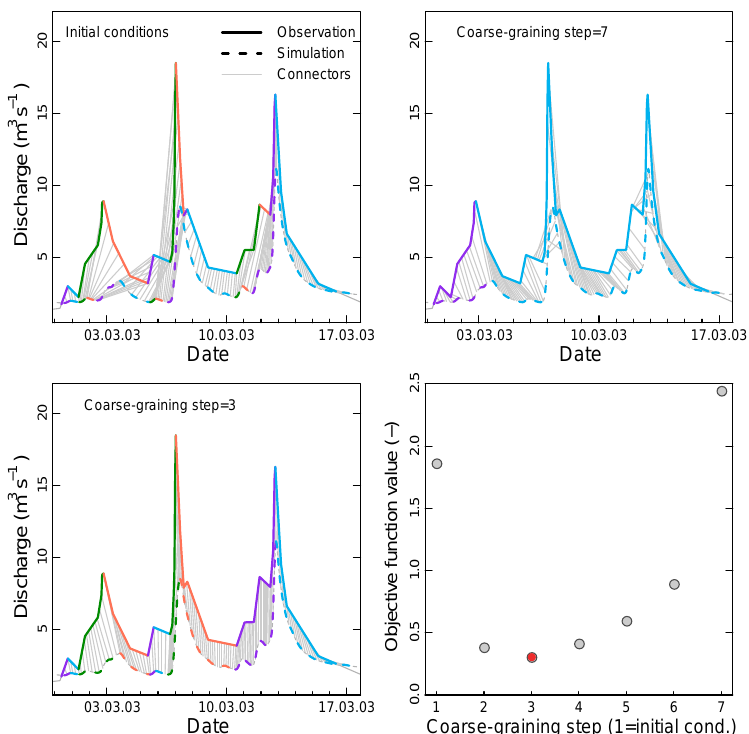
Figure 3. Coarse-graining steps: all plots contain data from the same multi-peak discharge event but for different levels of coarse-graining. The initial conditions (top left panel) are characterized by a large number of poorly matching simulated (dashed) and observed (solid) segments as indicated by the non-intuitively placed SD connectors (grey lines). Segments required to match according to the chronological order constraint of SD are indicated by matching colours. In the last coarse-graining step (top right panel) the connectors are placed more meaningfully but the representation of the entire event by only two segments (one rise, one fall) appears inadequately coarse. The optimal level of coarse-graining, here reached at step three, yields visually acceptable connectors while preserving a detailed segment structure (bottom left panel). This step is associated with a minimum of the coarse-graining objective function (Eq. 2), indicated by the red dot in the bottom right panel. Grey dots indicated the values of the objective function for all other coarse-graining